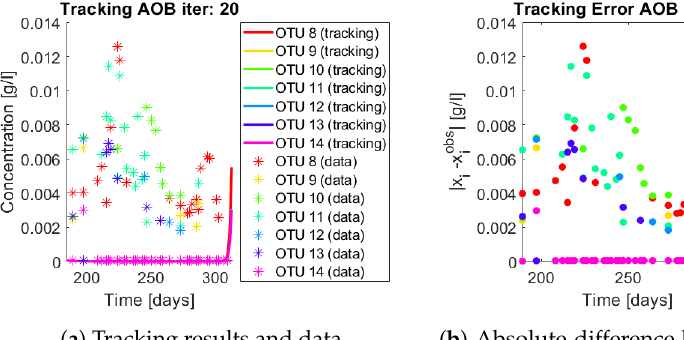
Figure 15. Results for OTU 1-7 (AOB).